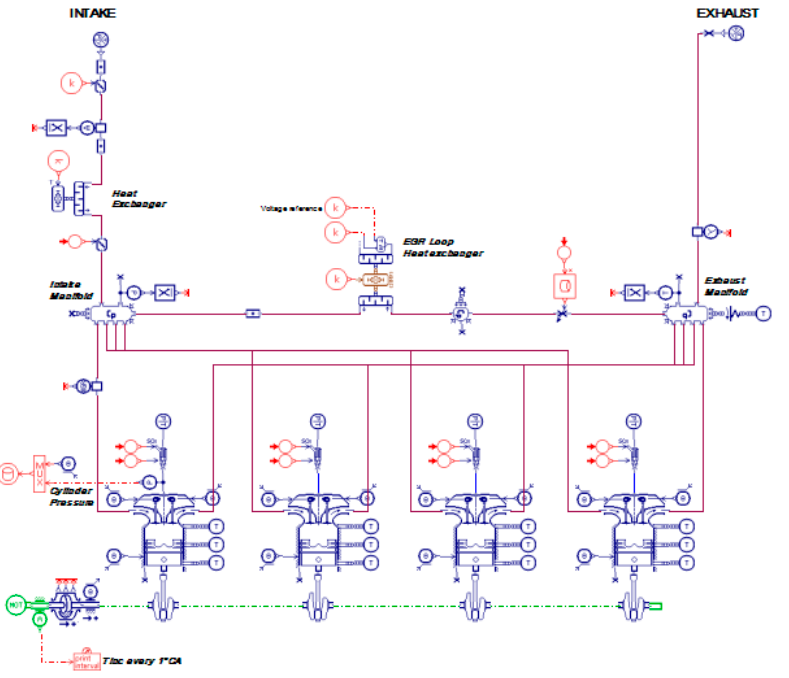
Figure 12. Diesel 1.9 dm 3 engine without a hybrid turbocharger simulated (naturally aspired) with AMESim software.